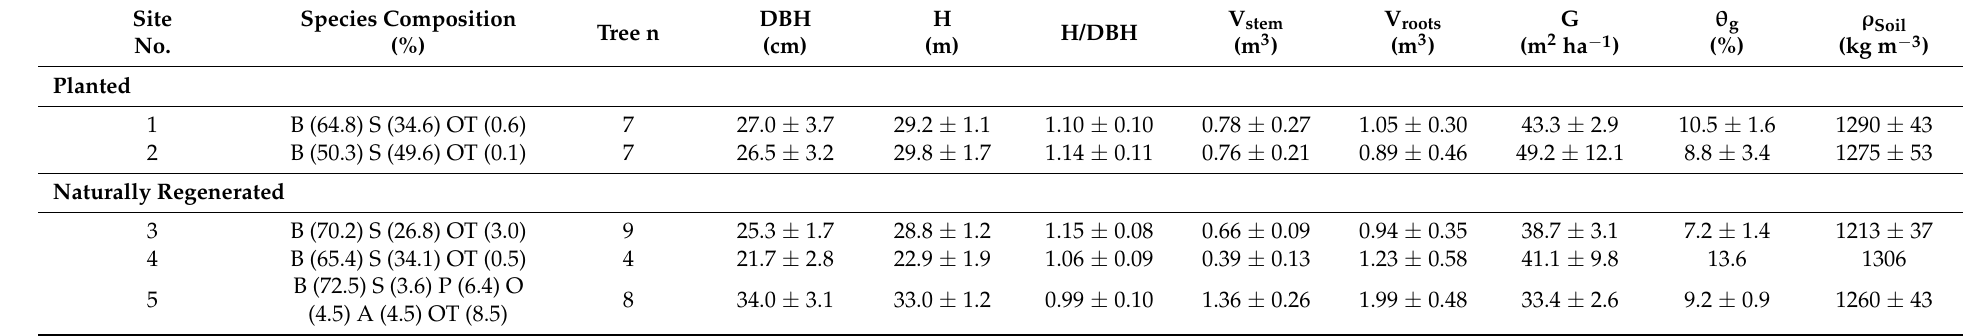
Table 1. Stands’ species composition (proportion from the total basal area), the number (Tree n), mean ( ± 95% confidence interval) diameter at breast height (DBH), height (H), height–diameter ratio (H/DBH), stem–wood volume (V stem ), soil–root plate volume (V roots ) of the sampled trees, as well as the local (at 12.61 m distance from the sampled tree) stand basal area (G), soil gravimetric water content ( θ g ) and soil density ( ρ Soil ). Tree species are abbreviated as follows: B—silver birch ( Betula pendula Roth.), S—Norway spruce ( Picea abies (L.) H.Karst.), A—common aspen ( Populus tremula L.); P—Scots pine ( Pinus sylvestris L.), O—common oak (